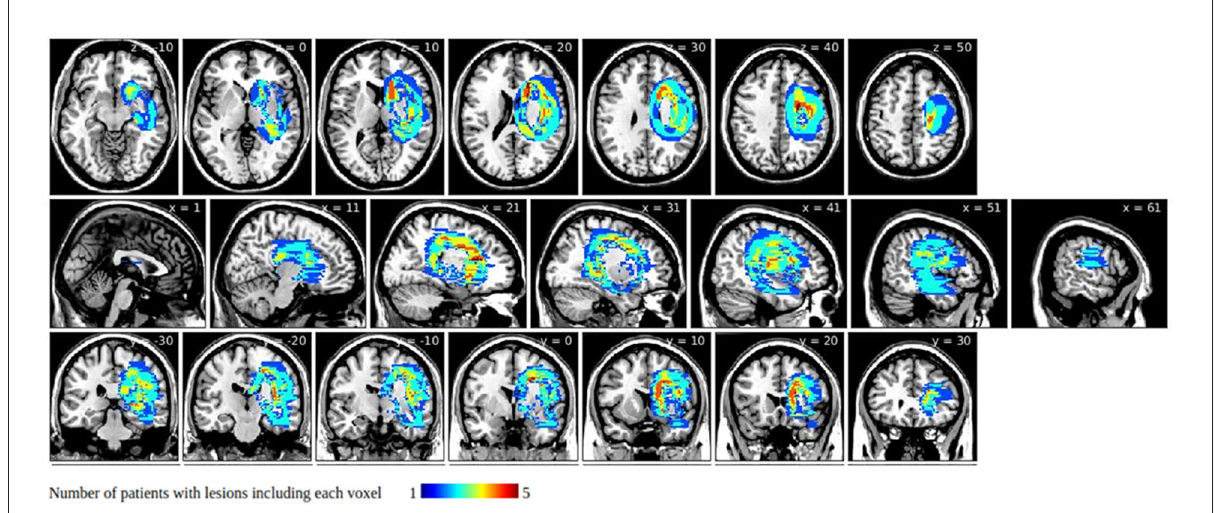
FIGURE1 Symptom-related lesions obtained by subtracting group-level unilateral spatial neglect (USN)(–) lesions from group-level USN( + ) lesions. Warmer colors indicate larger numbers of subjects with overlapping lesions in the USN( + ) group.